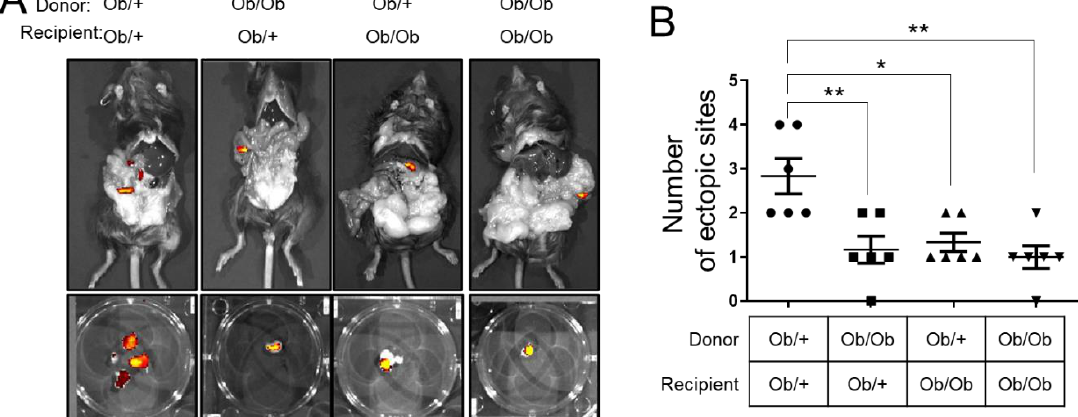
Figure 4. Effects of obesity with leptin deficiency on endometriosis. ( A ) Representative Cy5.5 signaling of ob /+ and ob / ob recipient mice with ob /+ and ob / ob endometriotic lesions. Endometriosis was surgically induced in 8-week-old ob /+ or ob / ob female recipients of donor uterine fragments from control ob /+ or ob / ob uteri labeled with Cy5.5 dye-doped silica nanoparticles. ( B ) Quantification of data for the number of ectopic sites were significantly lower in different donor and recipient condition compared with heterozygous donor and heterozygous recipient. Data are represented as mean ± SEM. * p < 0.05 and ** p <